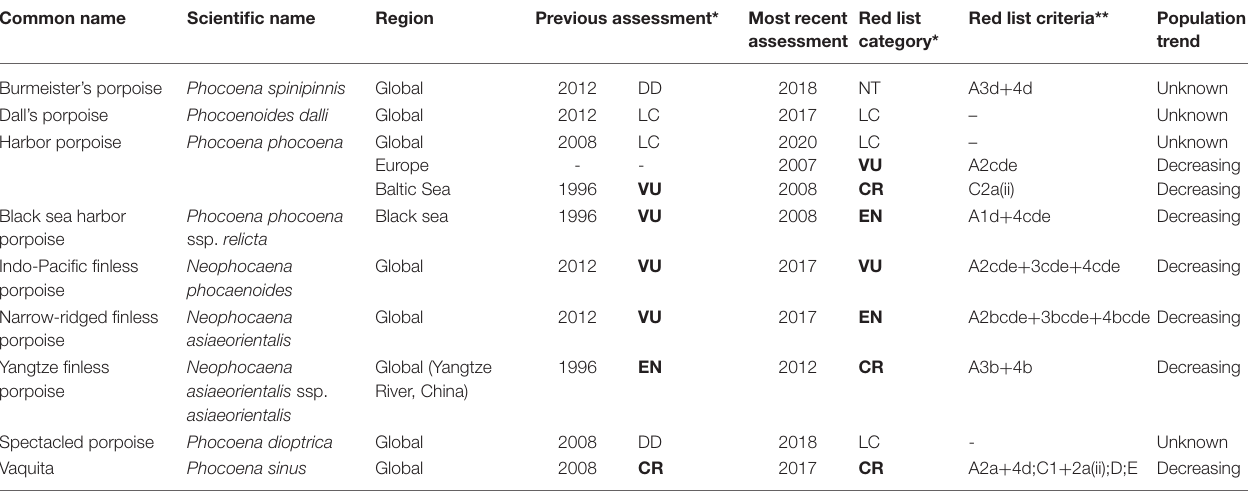
TABLE 1 | IUCN Red List data relating to porpoises including previous assessment category, current Red List category, Red List criteria, and population trend.